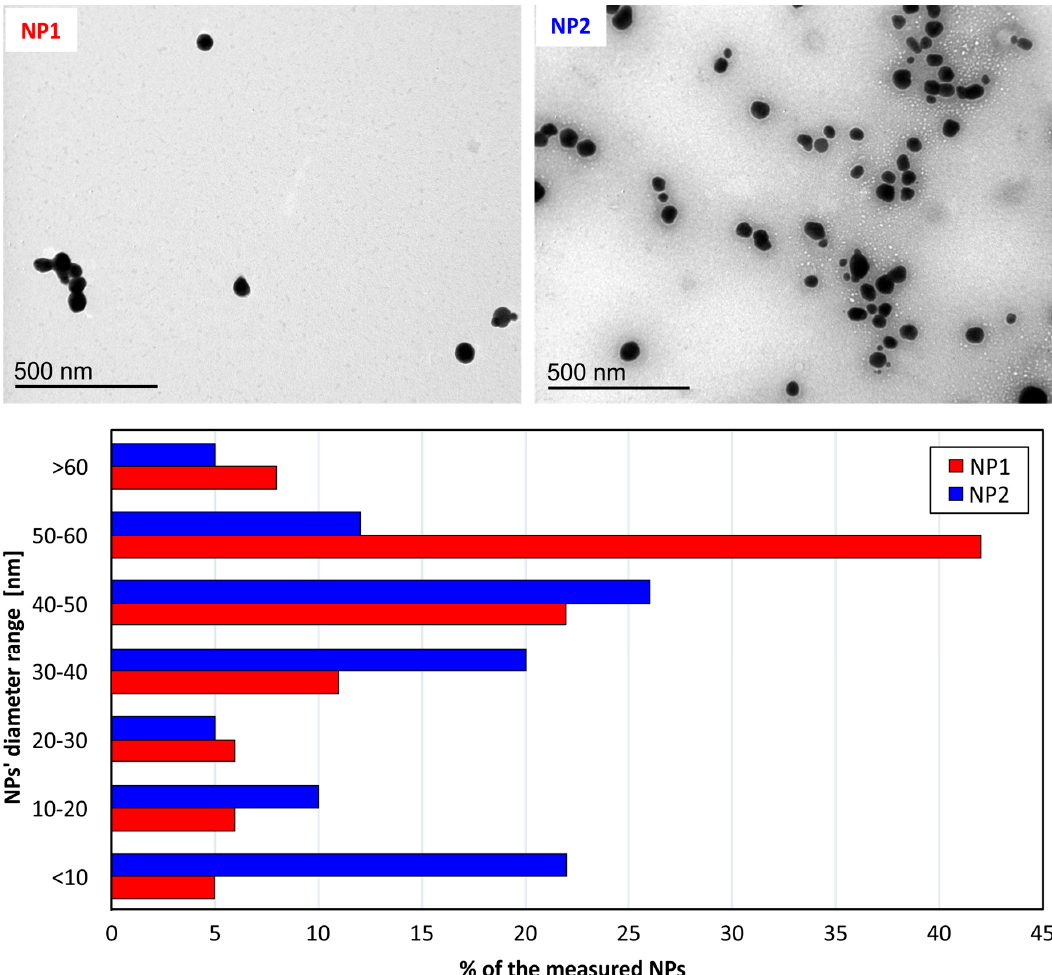
Figure 3. TEM images show the shape and size of both nanoparticles variations NP1 and NP2 with a concentration of 75 μ g/mL. The graph at the bottom presents the size distribution of AgNPs.